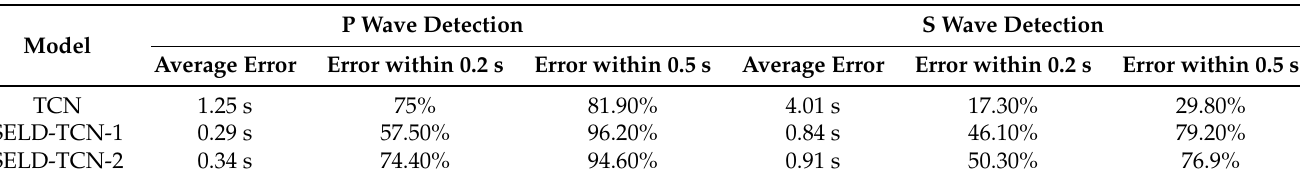
Table 1. A comparison of the detection of P and S waves between the TCN and the SELD-TCN models.